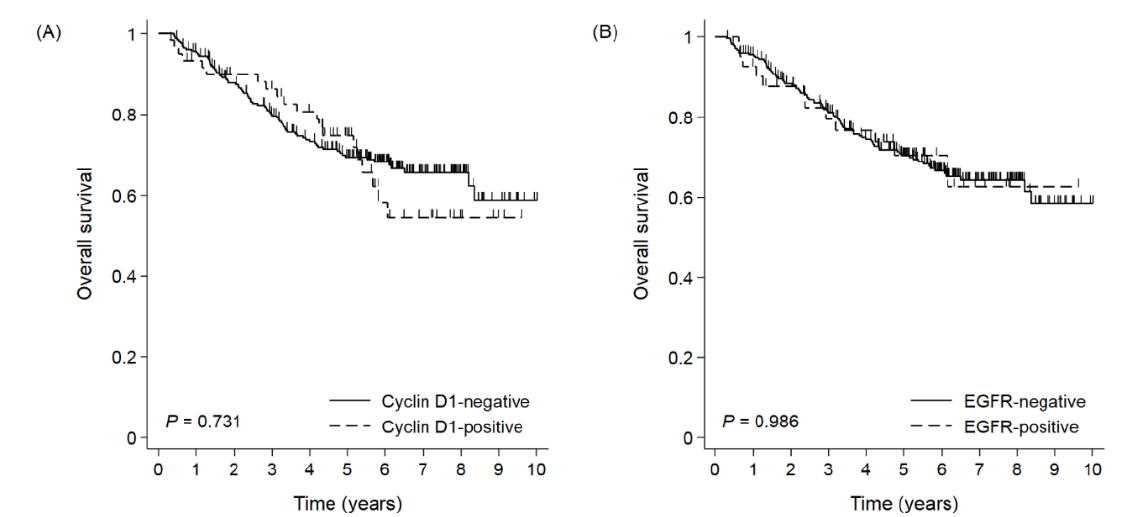
Figure 2. Overall survival by ( A ) cyclin D1 and ( B ) EGFR positivity in total cohort.